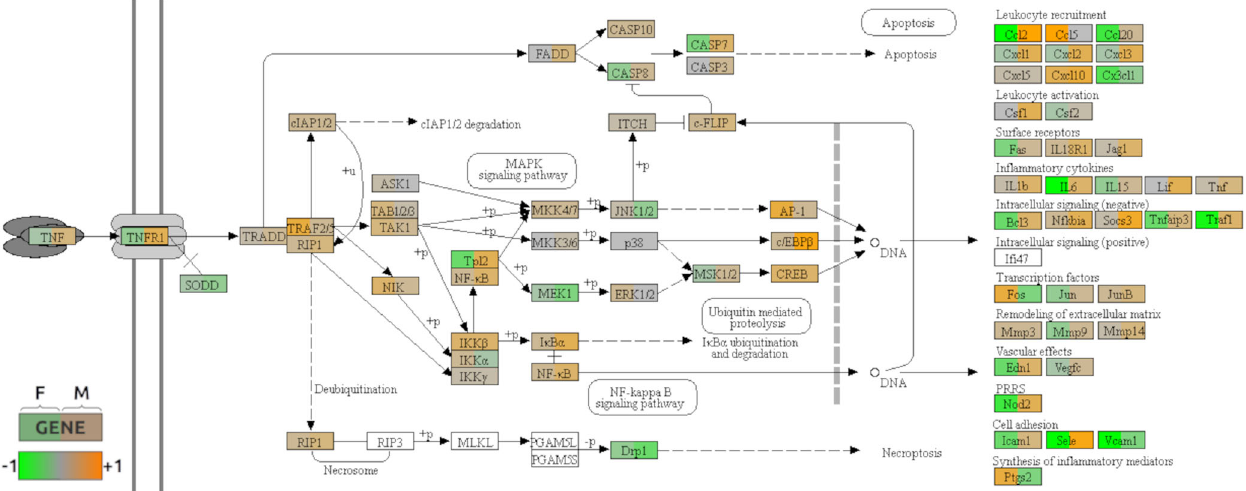
Fig. 2 Overlay of the differential expression statistics on part of the map for the TNF signaling pathway. Each gene box has colors re fl ecting the cross-study log. fold change in the differential expression analyses for the female (left) and male analyses (right). Up- and down- expression in PD patients are respectively indicated by the orange and green color scales. The pathway map has been extracted from the KEGG database and the rendering was obtained using the software Pathview.